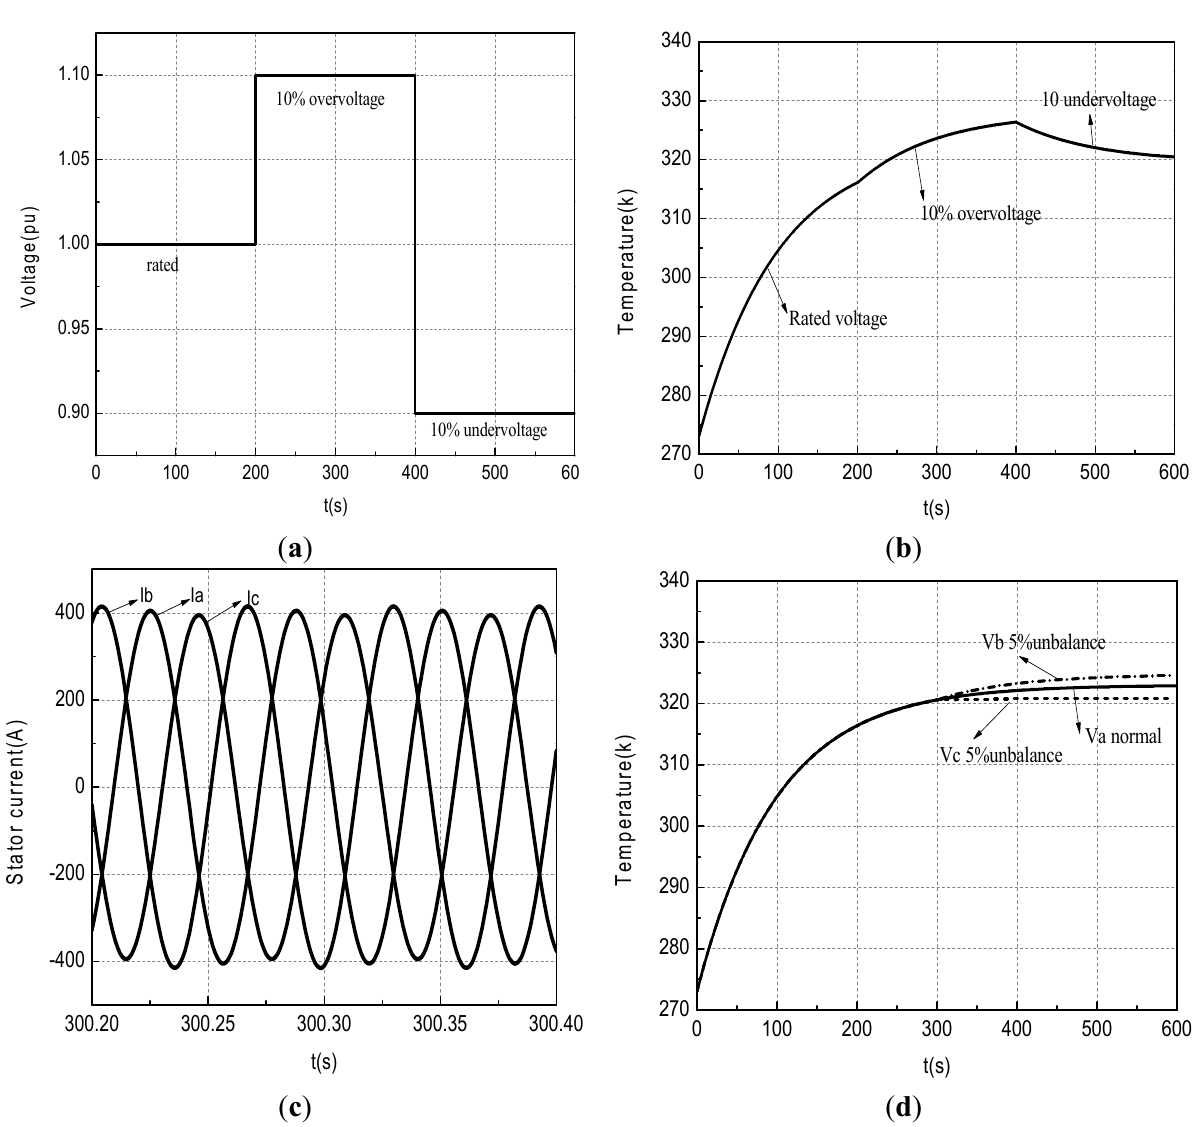
Figure 12. DFIG stator winding temperature variation due to different PVUR situations. ( a ) Three-phase voltage unbalance; ( b ) Temperature for three-phase unbalance; ( c ) b & c phase voltage unbalance; ( d ) Temperature for two-phase